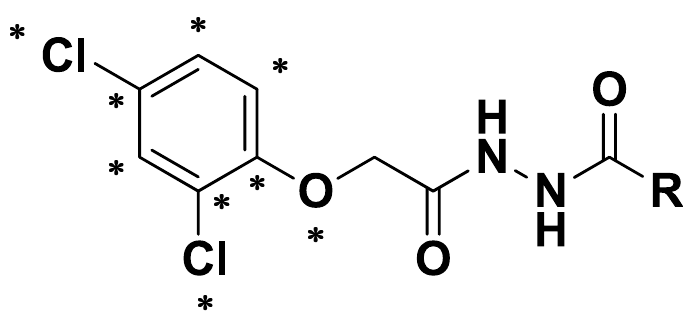
Figure 4. The asterisk skeleton of title compounds.